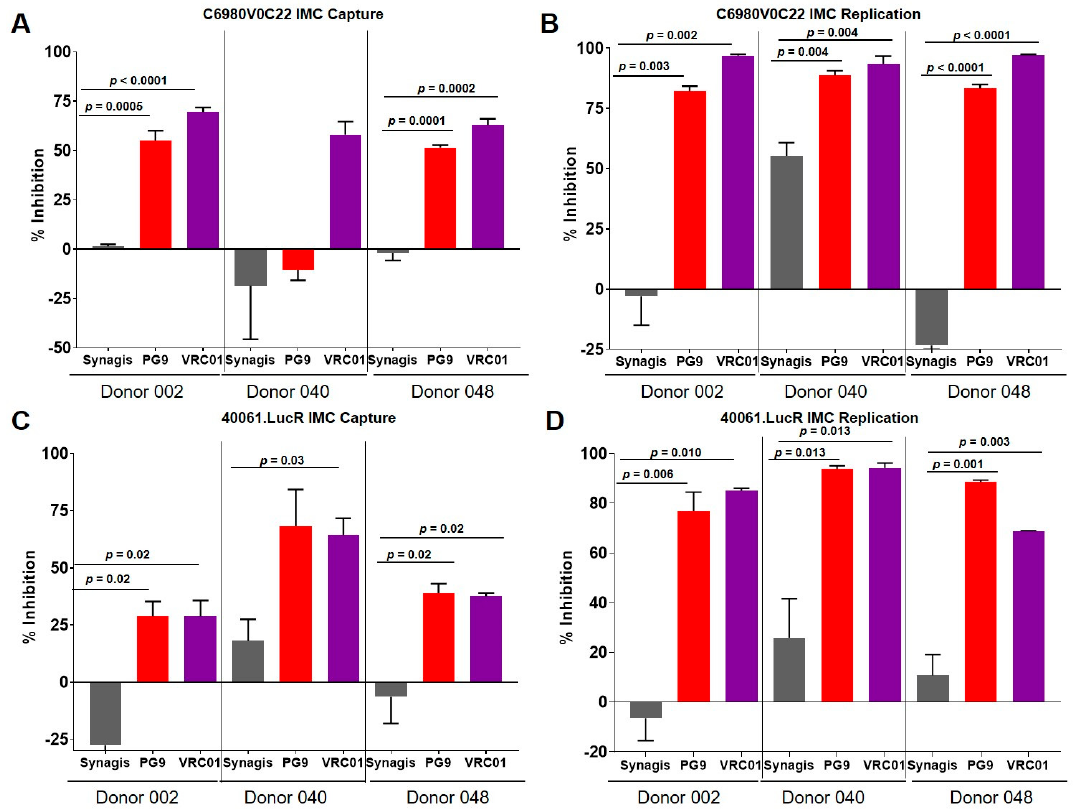
Figure 5. bNAbs inhibited virus capture and replication of acute IMCs in isolated CD4 + T cells. ( A ) PG9 inhibited virus capture of the subtype C IMC, C6980V0C22, in purified CD4 + T cells in two out of the three donors examined. VRC01 inhibited virus capture of C6980V0C22 in CD4 + T cells from all three donors. ( B ) The two bNAbs significantly inhibited virus replication of C6980V0C22 in CD4 + T cells from the three donors. ( C ) The two bNAbs inhibited capture of the subtype CRF01_AE IMC, 40061.LucR with the CD4 + T cells from all three donors. ( D ) Both PG9 and VRC01 inhibited virus replication of 40061.LucR and CD4 + T cells. Significant inhibition ( p = 0.01 or p < 0.01) was observed for both bNAbs and with all three donors examined. The data are shown as bar graphs representing mean ± SEM and are from at least 2 independent experiments performed in triplicate.